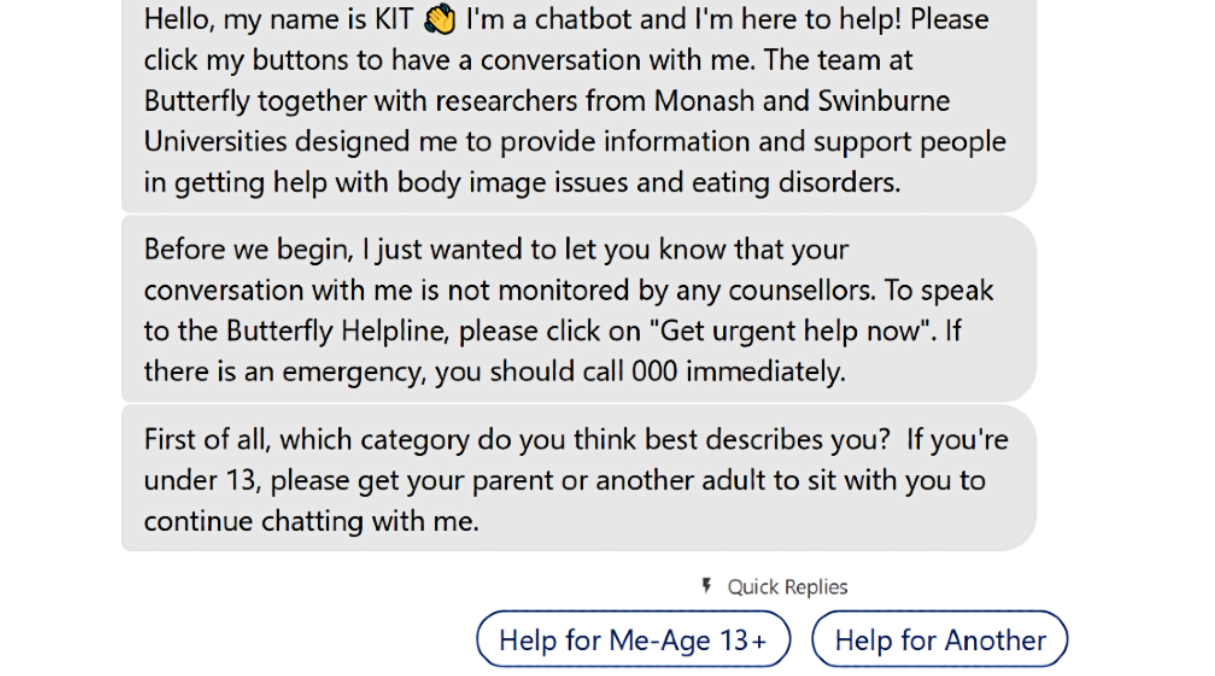
For people aged 13 years or above, KIT